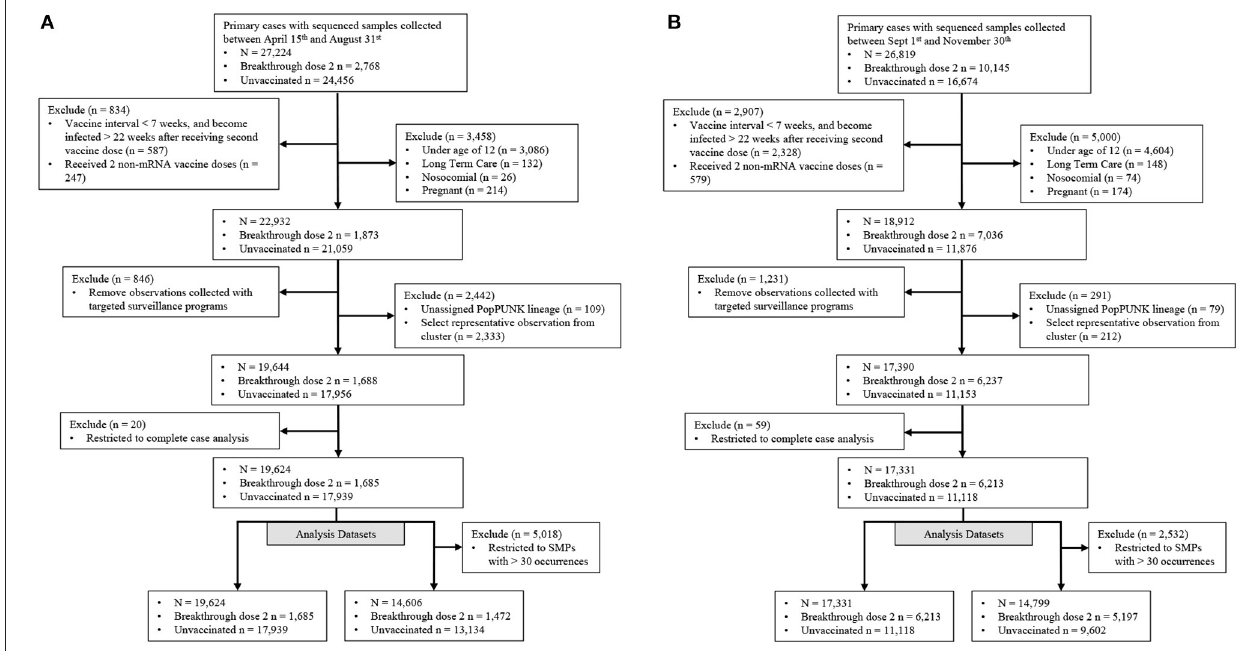
FIGURE 2 | Filtration steps for samples in both Delta emerging and predominance periods. Samples were stratified into two distinct periods representing (A) a time when the Delta-variant was emerging and (B) when the Delta-variant was the major variant circulating. Targeted surveillance includes individuals regularly tested for work and travel